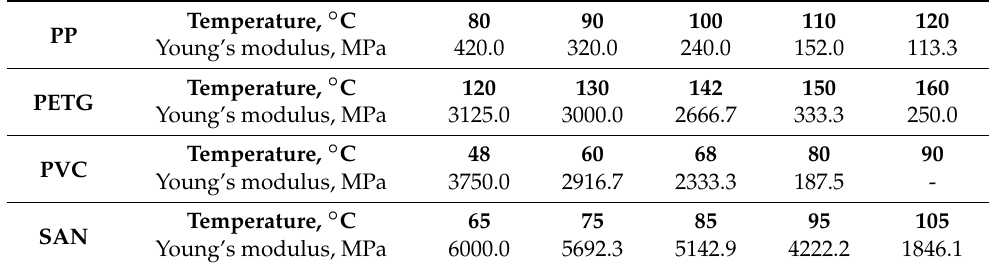
Table 2. Young’s modulus of PP, PETG, PVC and SAN thermoplastics at different temperatures.